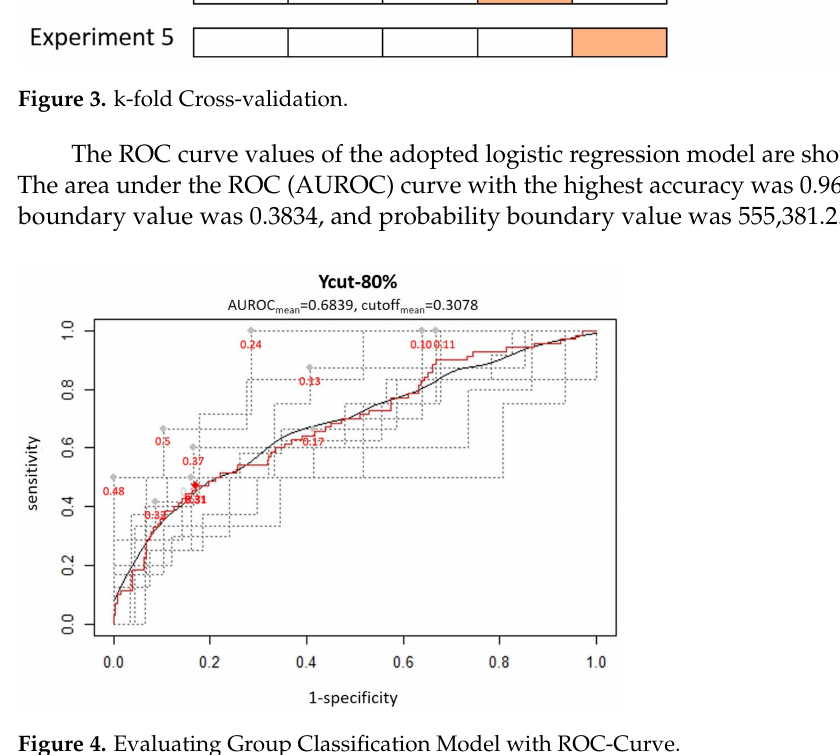
Figure 4. Evaluating Group Classification Model with